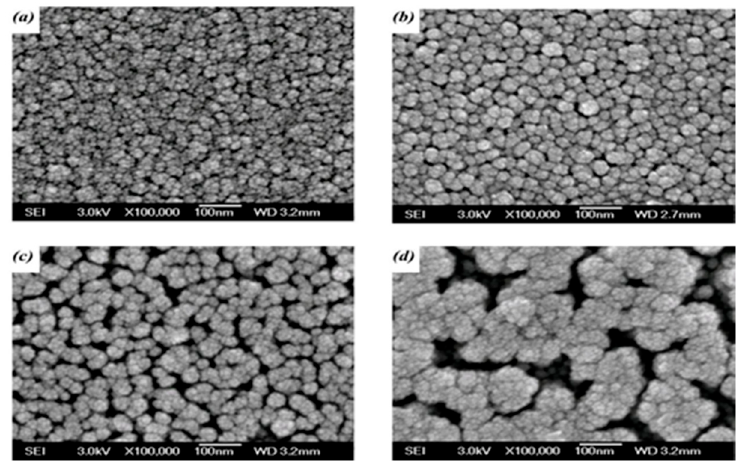
Figure 5. Surface morphologies of the a-TiO x film deposited onto ( a ) untreated base layer; and SFE-treated base layers for ( b ) 10; ( c ) 20; and ( d ) 35 s; respectively.